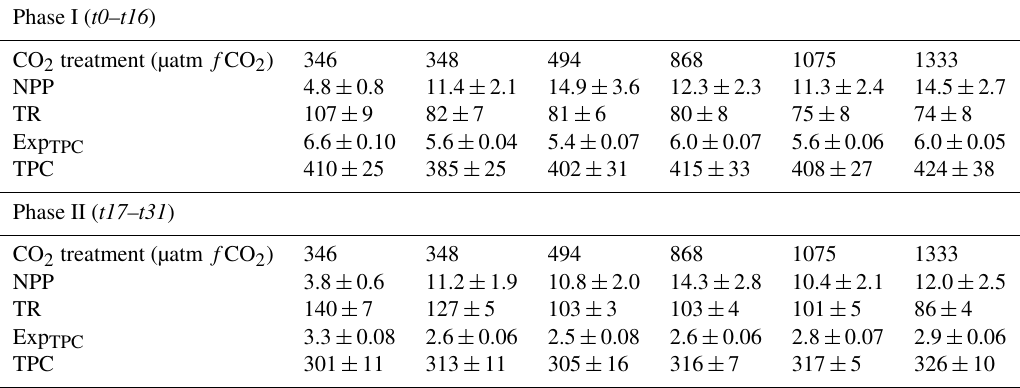
Table 1. Average net primary production (NPP), total respiration (TR) and exported total particulate carbon (Exp TPC ) in mmolCm − 2 d − 1 ± SE during Phase I and Phase II of the experiment. The pool of total particulate carbon (TPC) is the average during the two periods in mmolCm − 2 ± SE. The standard error was calculated throughout the period: Phase I, n = 9; Phase II, n = 7. NPP and TR were corrected for the missing measuring days during Phase I. TR was measured as O 2 consumption and for comparison with carbon fixation we used a respiratory quotient (RQ) of